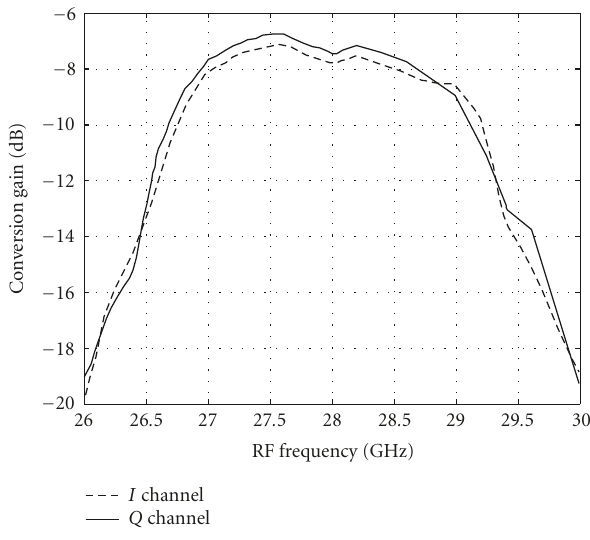
Figure 13: BER of the 16 QAM signal versus E b /N 0 as a function of ε . From left to right ε = 0,0 . 08,0 . 16. Dashed line represents BER calculated-from the closed form formula.